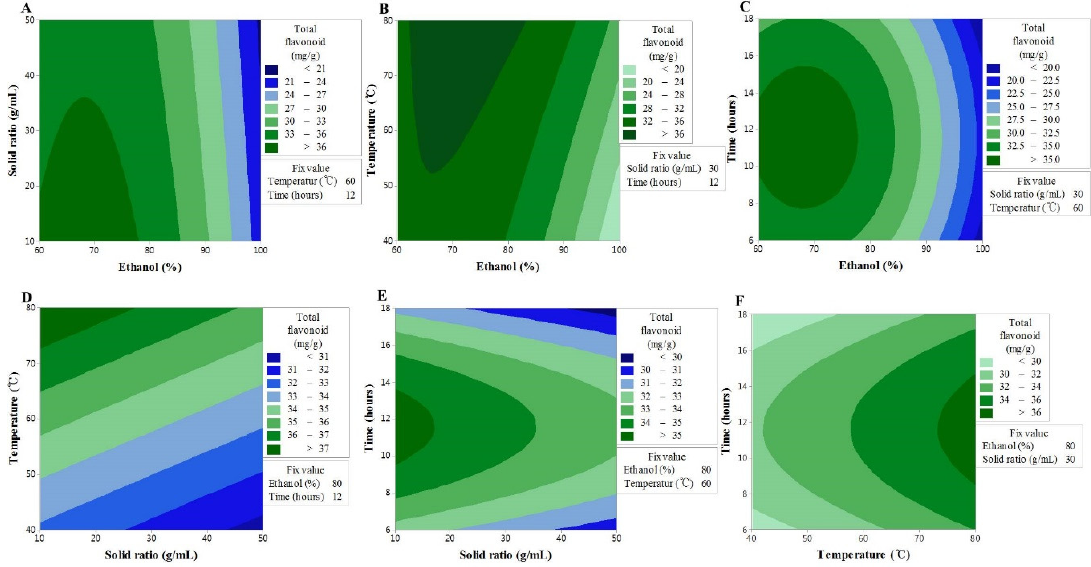
Figure 1. Contour plots showing the effect of ethanol concentration, solvent ratios, temperature, and time on total flavonoid content. ( A ) solid ratios (g/mL) vs. ethanol concentration (%); ( B ) temperature (°C) vs. ethanol concentration (%); ( C ) time (h) vs. US ethanol concentration (%); ( D ) temperature (°C) vs solid ratios (g/mL); ( E ) time (h) vs solid ratios (g/mL); ( F ) time (h) vs temperature (°C).